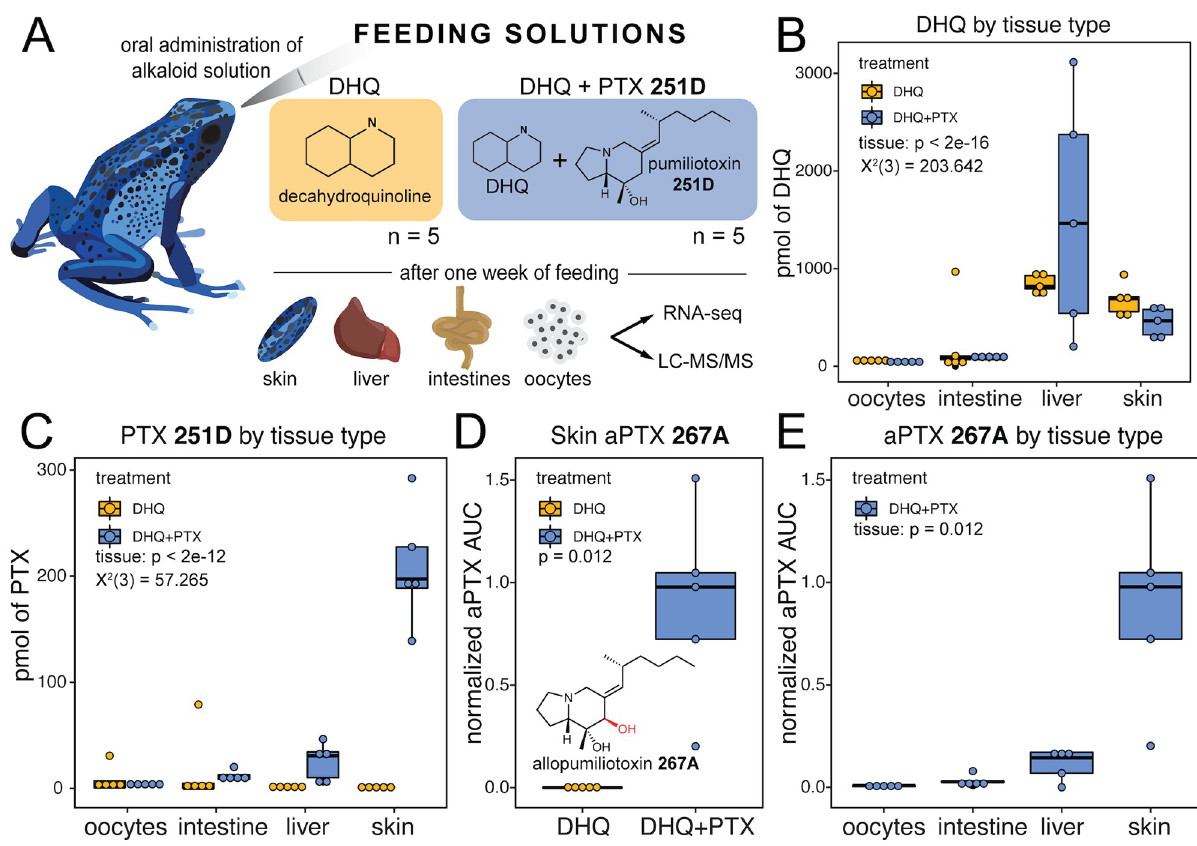
Fig 1. Alkaloid sequestration in different tissue types. Boxplots showing abundance of different compounds in different tissues and treatment types, with DHQ-fed frogs in yellow and DHQ+PTX-fed frogs in blue. (A) Frogs were orally administered either DHQ or DHQ+PTX once a day for five days. (B) DHQ abundance differed by tissue but not treatment group and was highest in the liver and skin (GLMM tissue, X 2 (3) = 203.642, p < 2e-16). (C) PTX levels differed by tissue and treatment, and were higher in the liver and skin of the DHQ+PTX fed group (GLMM tissue:treatment, X 2 (3) = 57.265, p < 2e-12). (D) The hydroxylated metabolite aPTX was found in the DHQ+PTX fed frogs (Wilcoxon test, W = 0, p-value = 0.012, n = 5). (E) aPTX abundance differed across tissues within the DHQ-PTX group (Kruskal-Wallis, X 2 (3) = 13.727, p = 0.003), and was found primarily in the skin, with some in the